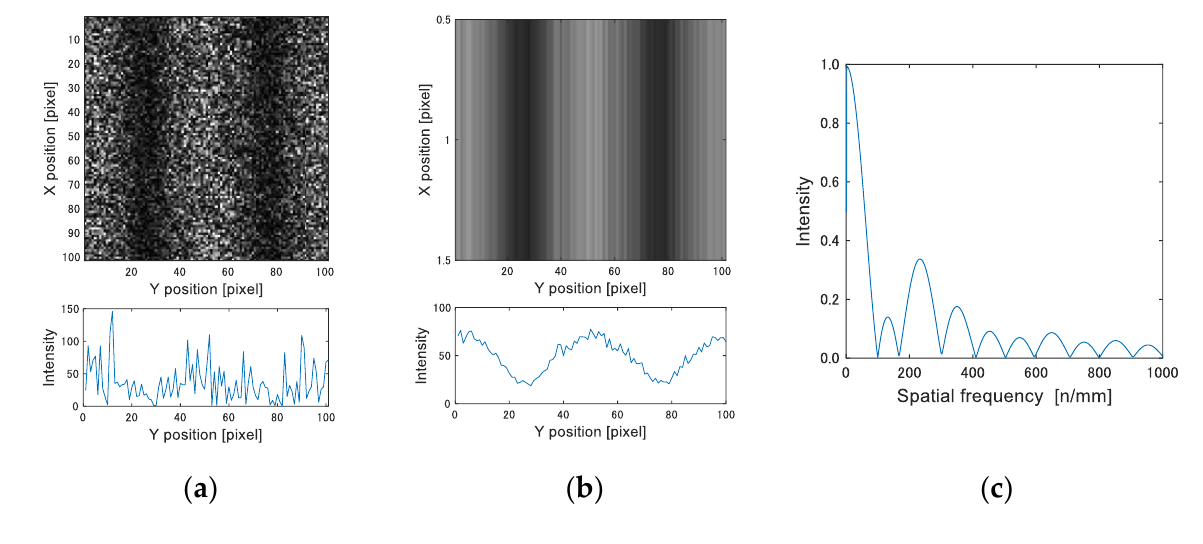
Figure 8. Fringe image analysis by FFT: ( a ) fringe image and intensity profile; ( b ) averaged intensity profile; and ( c ) FFT spectrum.